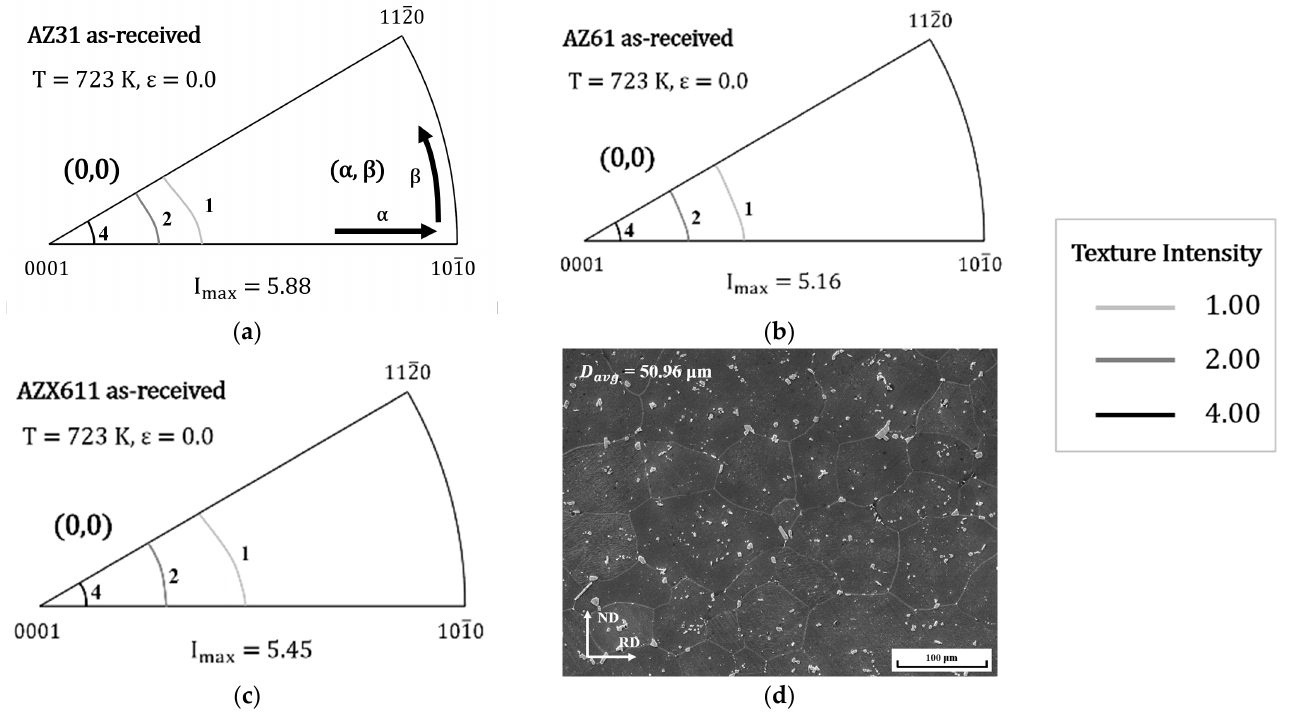
Figure 1. The (0001) pole figure of ( a ) AZ31, ( b ) AZ61 and ( c ) AZX611 as-received specimen and ( d ) the microstructure of AZX611. ( d ) the microstructure of